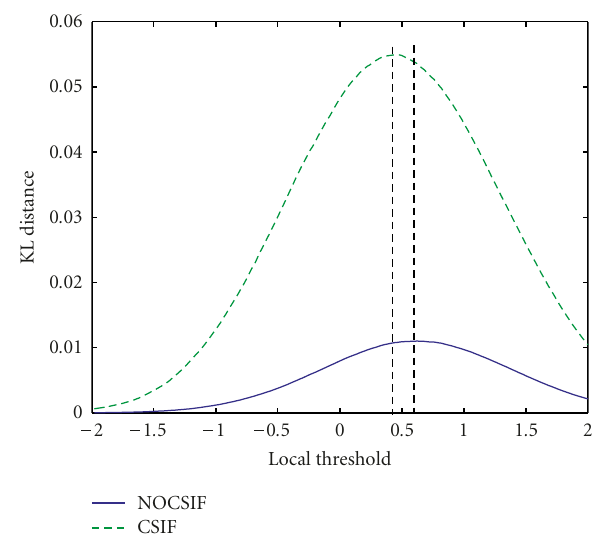
Figure 3: Average error probability versus channel SNR for non- identical channel distribution.